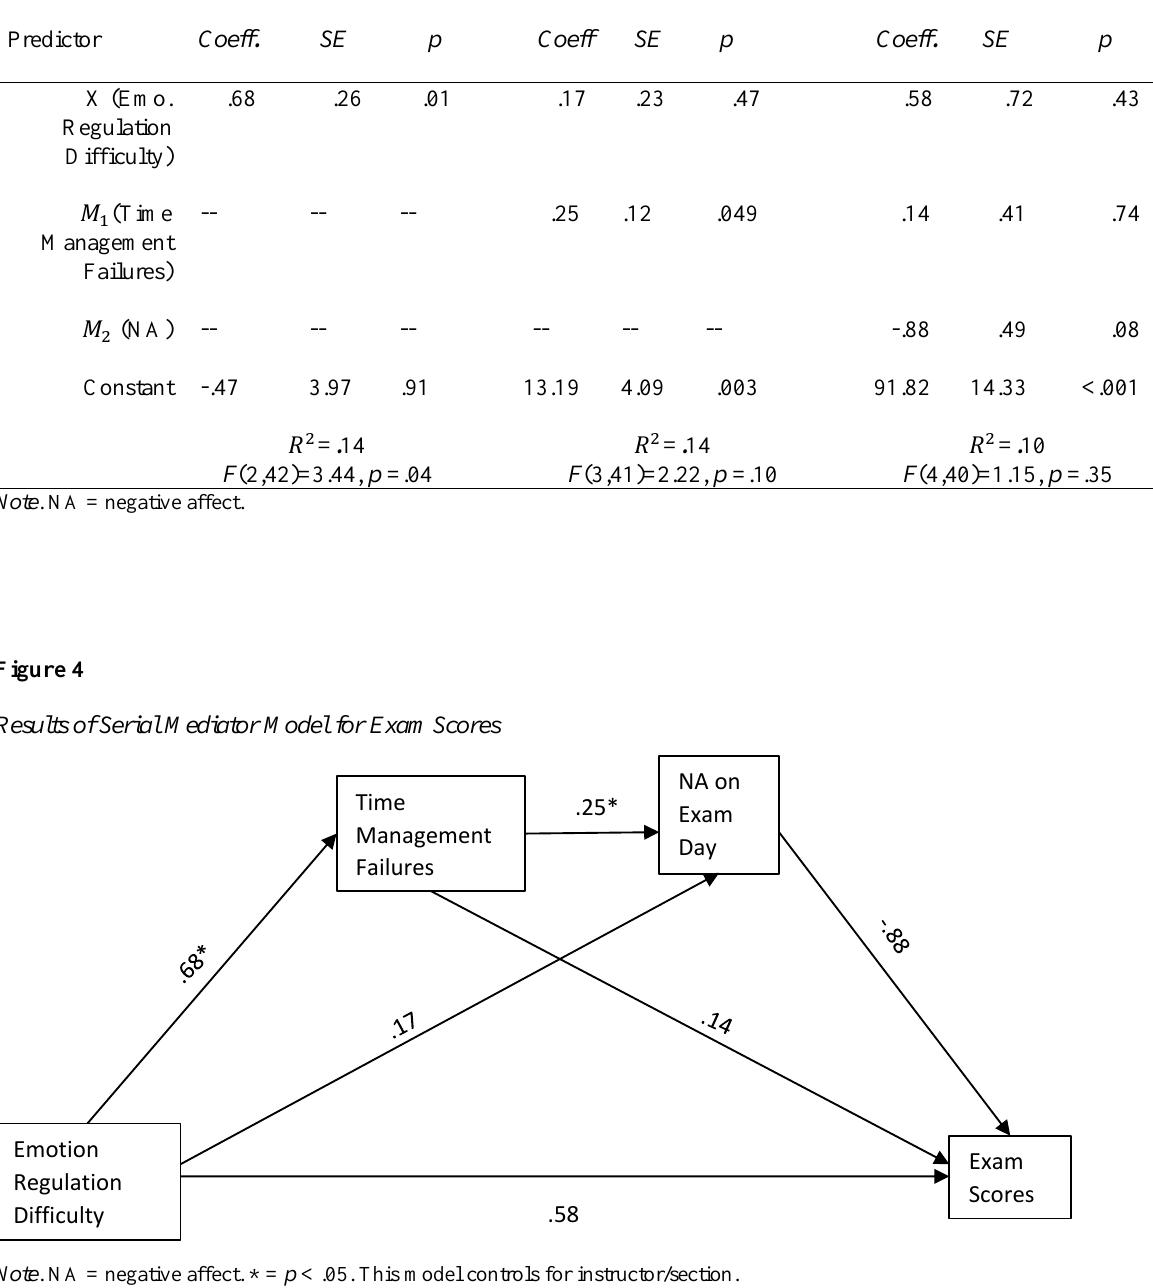
Note . NA = negative affect. * = p < .05. This model controls for